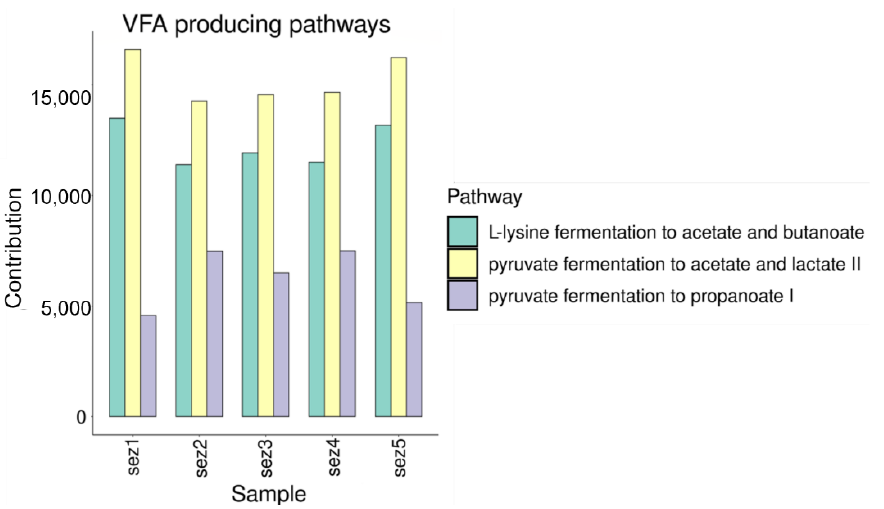
Figure 10. Contributions to pathways involved in VFA production. The numbers reported are the mean of the sum of contributions per taxa in each AD section, calculated by PICRUSt2.